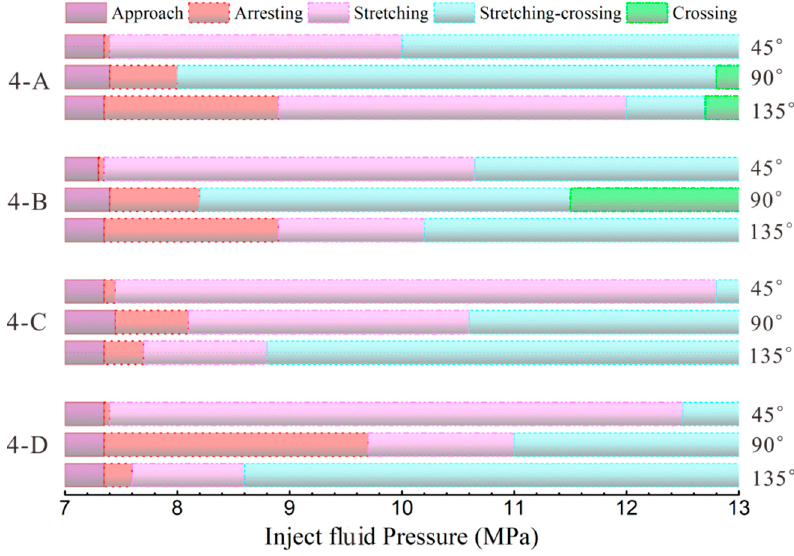
Figure 13. Fluid pressure zones for different interaction modes.